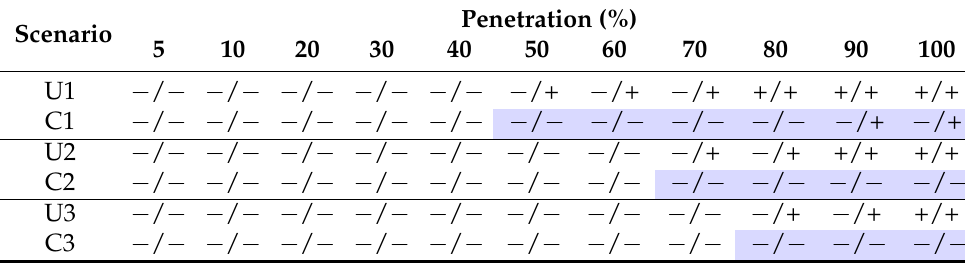
Table 3. Compliance with the EN50160 voltage standards for the six scenarios (uncontrolled U1–U3 and controlled C1–C3) for the range of penetrations; − / − : compliant with the time limit and compliant with the minimum voltage limit; − /+: compliant with the time limit and violation of the minimum voltage limit; +/ − : violation of the time limit and compliant with the minimum voltage limit; +/+ : violation of the time limit and violation of the minimum voltage limit. Shaded text is used to highlight the mitigation effects achieved by the droop